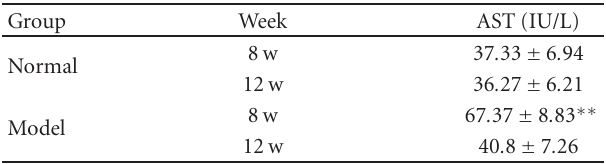
P < . 05 , compared to the normal